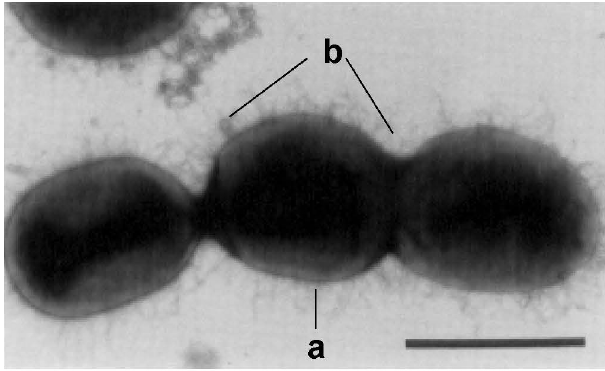
Figure 3. Brackiella oedipodis – bar = 100µm. (a) Bacterial cell wall, (b) abundant